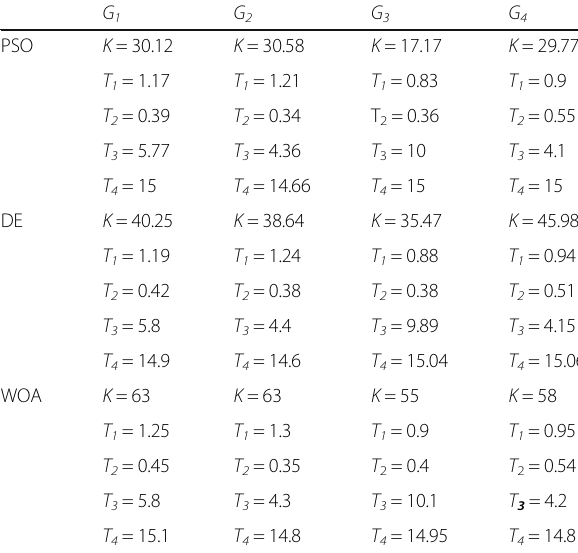
Table 5 Evolved parameters with WOA, DE and PSO